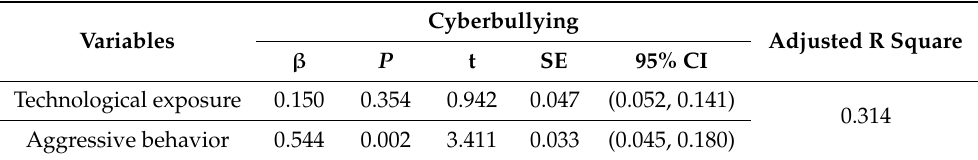
Table 5. Results from the regression analysis. Variables Technological